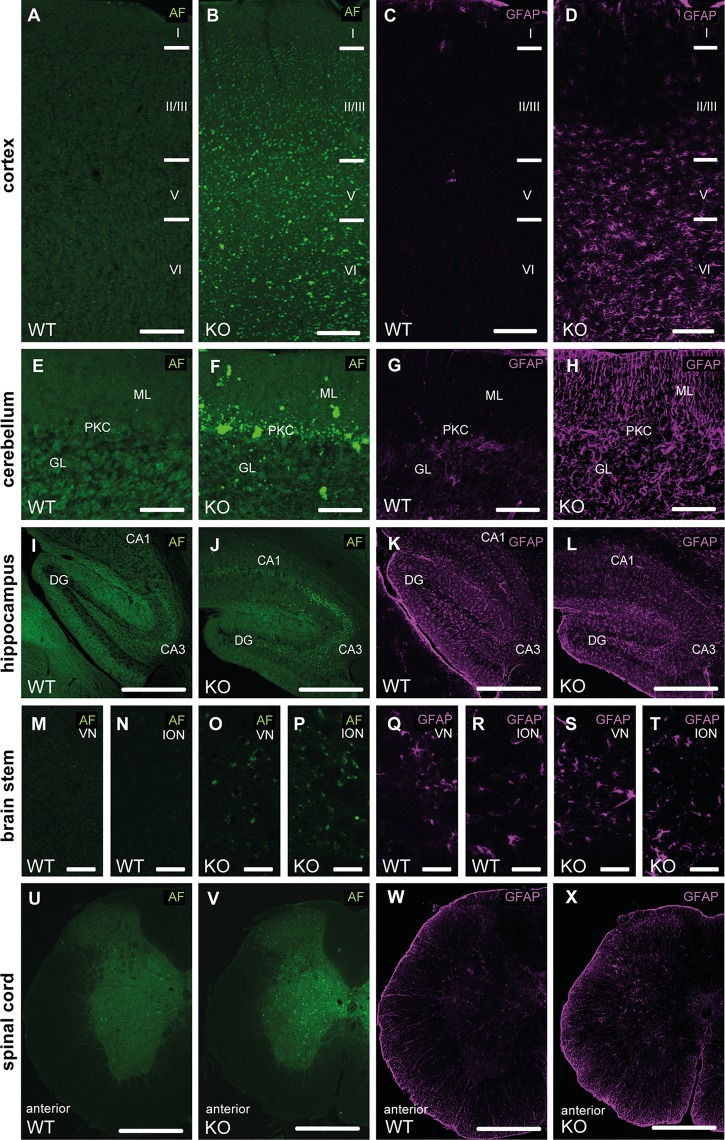
Autofluorescence and GFAP immunoreactivity in different regions of the central nervous system.
(A-D) At 16 months of age we observed an accumulation of autofluoerscent material in cortical neurons of Spatacsin KO mice (B). The neuron loss was paralleled by an activation of astrocytes in Spatacsin KO mice as evident from glial fibrillary acidic protein (GFAP) stainings (D). Cortical layers are labeled (I–VI). (E-H) Accumulation of autofluorescent material was also obvious in the cerebellum of Spatacsin KO mice (F). As in the cortex the neuron loss was paralleled by an activation of astrocytes in Spatacsin KO mice (H). GL: granular cell layer, PKC: Purkinje cell layer, ML: molecular layer. (I-X) Though neurons in the hippocampus (I-J), vestibular nuclei (VN) (M,O), inferior olivary nucleus (ION) (N,P) and in the spinal cord (U,V) accumulate autofluorescent material, no activation of astroglia was observed for these regions (K,L,Q-T,W,X). Scale bars: 150 (A-H), 250 (I-L,U-X), and 50 μm (M-T). CA1: Cornu ammonis 1. CA3: Cornu ammonis 3. DG: dentate gyrus. AF: autofluorescence.